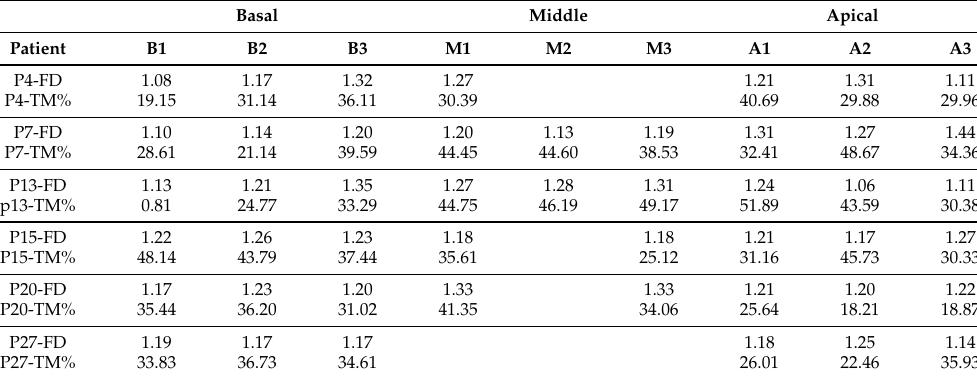
Table 4. Results of FD [16] and TM% (QLVTHCI) for each slice of patients P4, P7, P11, P13, P15, P20, and P27. Basal Middle Apical Patient B1